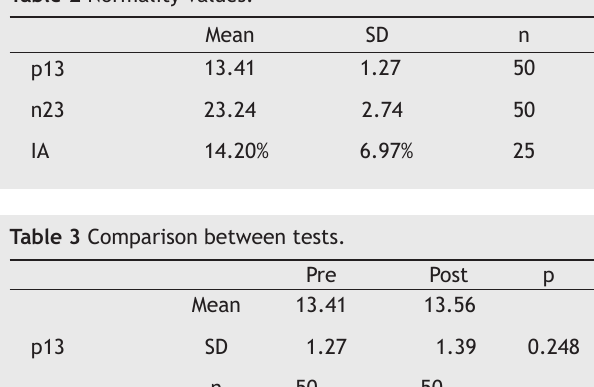
Table 2 Normality values.